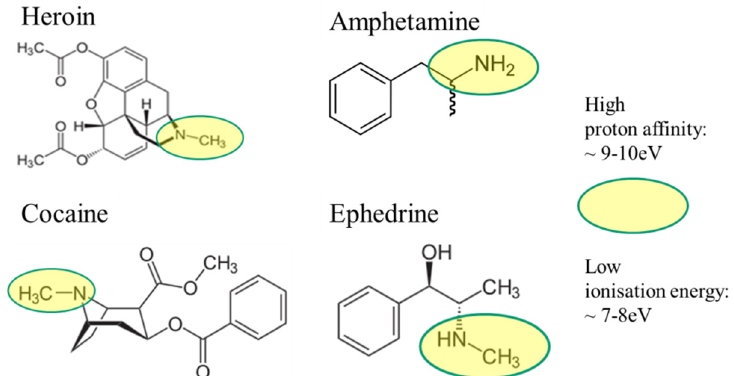
Figure 4. Molecular structure of illicit drugs. Ephedrine [32] is an easily available substitute for enabling efficient laboratory work. Amine functional groups are highlighted in yellow.